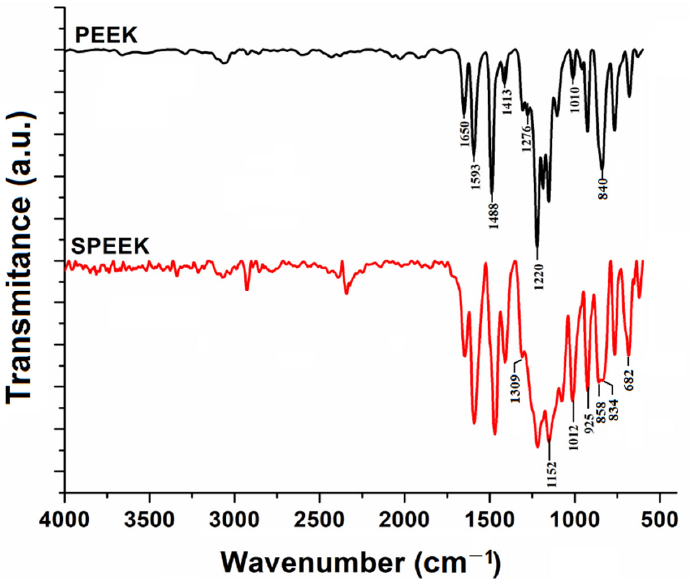
Figure 2. Infrared spectra (FTIR spectroscopy in ATR mode) for pristine polymer (PEEK) sample, and the sulfonated polymer (SPEEK) sample.